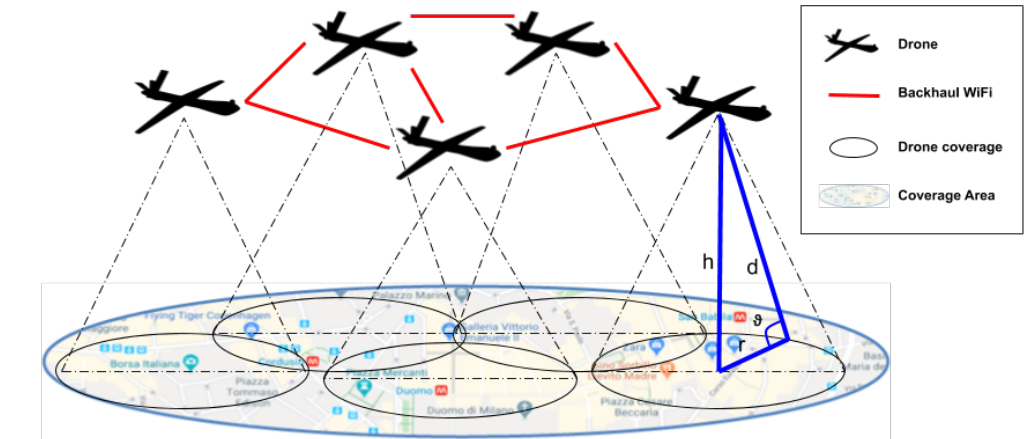
Figure 1. UAV/drone coverage footprint on the